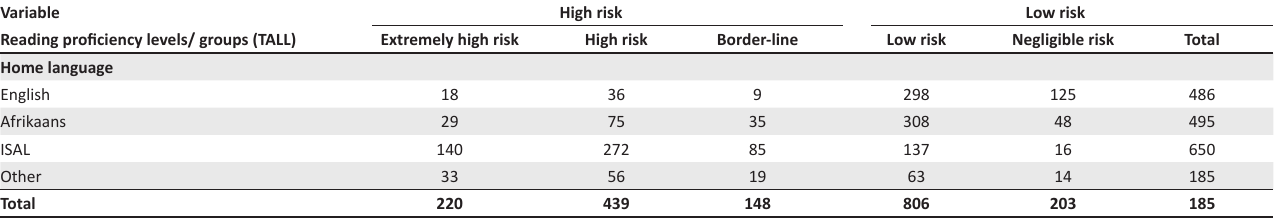
TABLE 1: Distribution of students’ reading proficiency levels in relation to their home language. Variable High risk Reading proficiency levels/ groups (TALL)